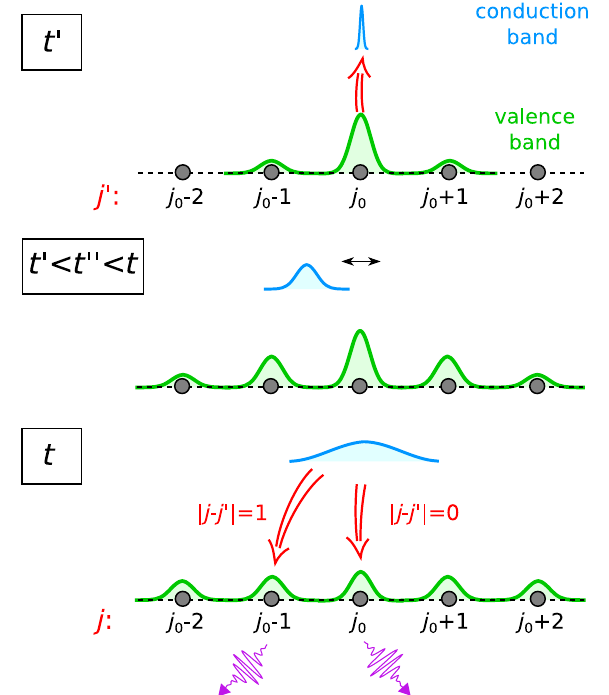
FIG. 1. Scheme of the electron excitation-recombination proc- ess for the HHG from the periodic lattice crystal. The periodic lattice is represented by gray disks along the black dashed line. The Wannier wave function is depicted by the green area. At time t 0 , a single-electron wave packet is excited from the j 0 th atomic site in the valence band to the conduction band. This wave packet is denoted by blue area. Then, during ð t 0 ; t Þ , it is accelerated within the conduction band by the driving laser field. Finally, at time t , the electron recombination takes place on different j atomic sites with the subsequent high-harmonic emissions, which are denoted by violet pulse oscillations. Note that the red arrows show excitation at j 0 ¼ j 0 and recombination at j ¼ j 0 and j 0 − 1 atomic